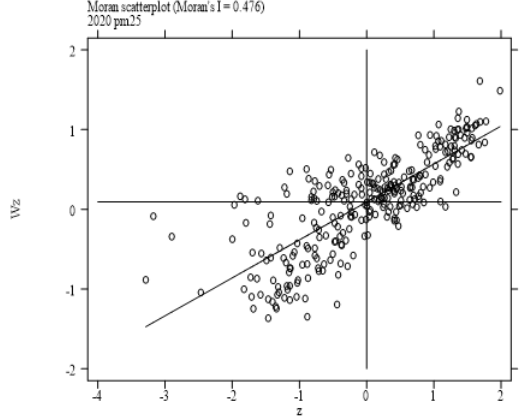
Figure 2. Moran’s scatter plot of air pollution.